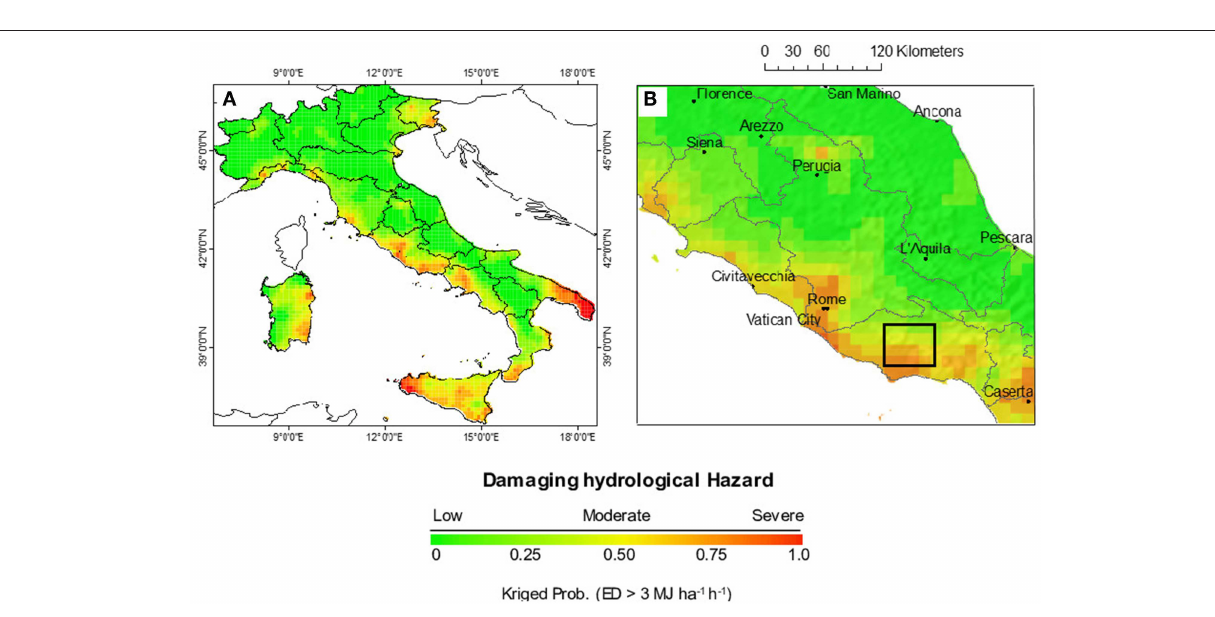
FIGURE 5 | Spatial patterns of kriged-probability maps exceeding the erosivity density threshold-value z k of 3 MJ ha − 1 h − 1 for (A) , October across Italy for the period 2002–2011 and (B) zoomed area in Central Italy where boundaries of river basin and main cities are over-imposed. The rectangular shape indicates the area for which the perspective view of Figure 6 was